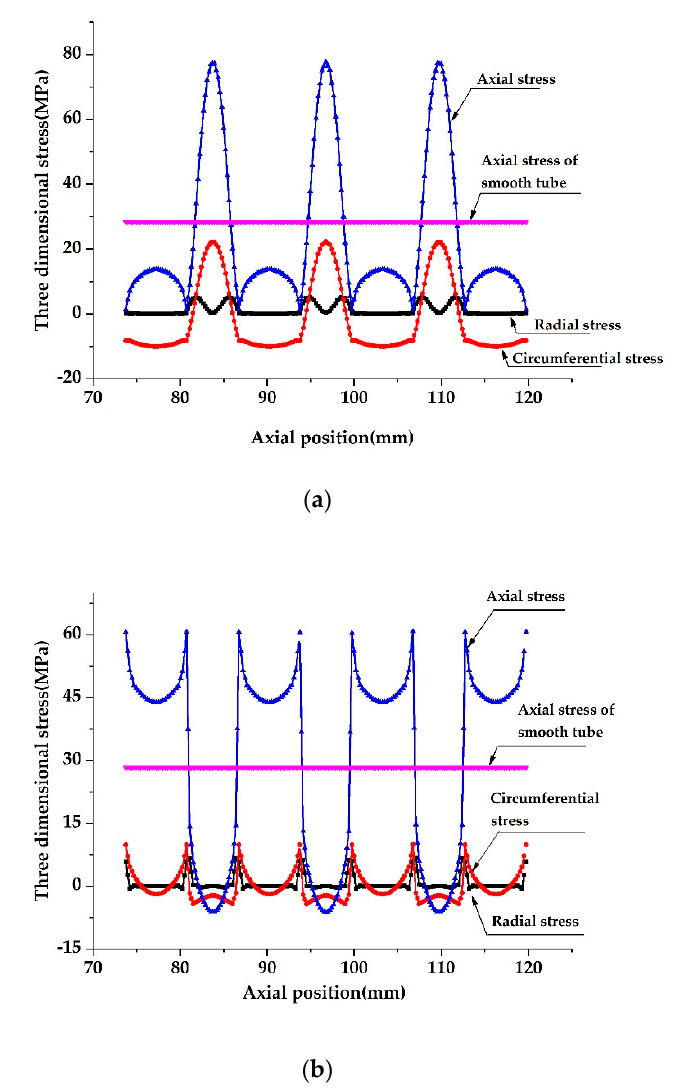
Figure 7. Stress distributions along tube length on inner and outer surfaces of the SG tubes: ( a ) On the outer surface, ( b ) On the inner surface. ( D = 25 mm, P = 13 mm, t = 2.5 mm, ε = 1 mm, F = 5000 N).